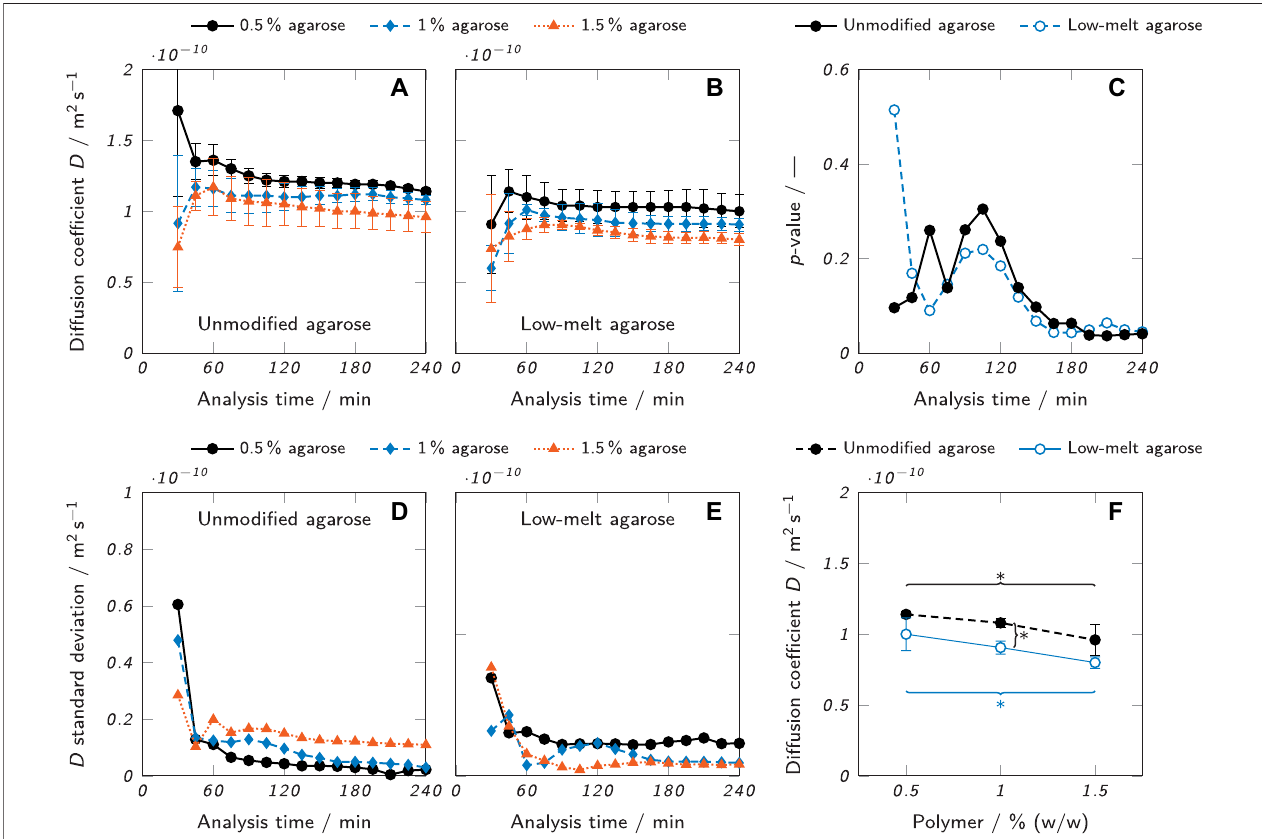
FIGURE 7 | Diffusion coef fi cient estimates at different analysis times for (A) unmodi fi ed agarose and (B) low-melt agarose hydrogels. (C) p -values of a one-way ANOVAtestingthenullhypothesis thatthereisnodifferenceamongthemeanvaluesof D forsamplesofdifferentagaroseconcentrations.(DandE)Standarddeviations for (D) unmodi fi ed and (E) low-melt agarose hydrogels resulting from the D estimates which were carried out as triplicates ( n = 3). (F) Diffusion coef fi cients for different concentrations of unmodi fi ed and low-melt agarose hydrogels obtained at an analysis time of 240 min. The results are presented as mean values ± standard deviation ( n = 3). Signi fi cant differences between the Equations are highlighted by asterisks (* p < 0.05, ** p <